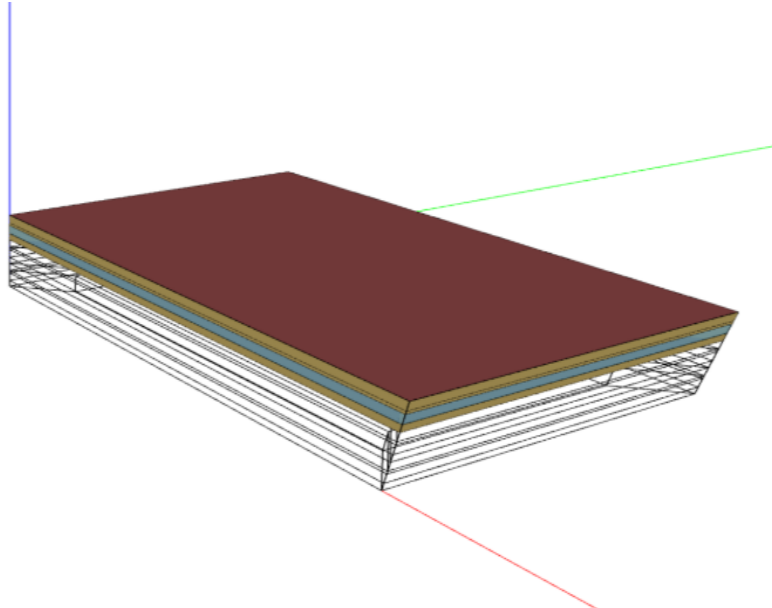
Figure 6. The building geometry.